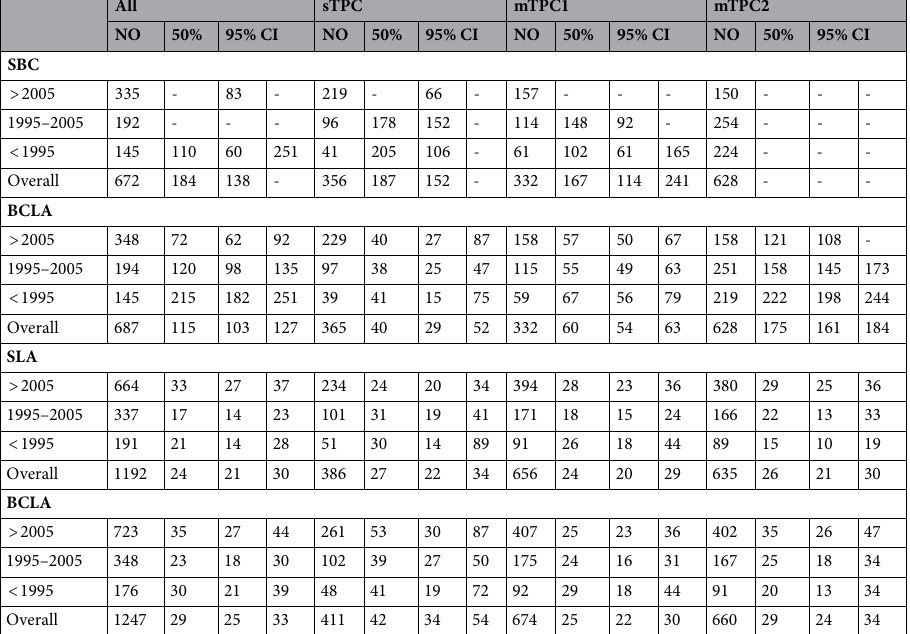
Table 2. Overall-survival analysis between patients with BCLA and matched single breast/lung cancer. BCLA breast cancer with subsequent primary lung cancer; SBC Single breast cancer; SLA Single lung cancer, − not reached; Overall survival was determined by median survival time (month).